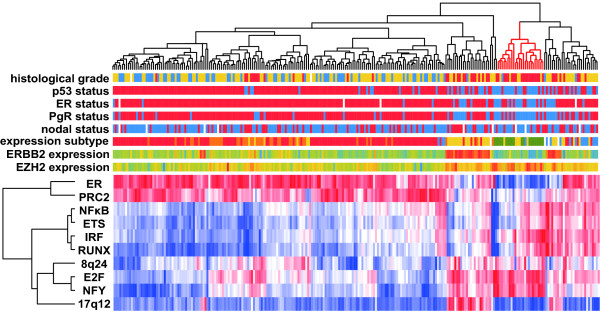
Clustering analysis of expression module activity profiles in breast tumors. Activity profiles of 10 expression modules extracted from breast cancer expression data were analyzed by hierarchical clustering. Red indicates increased activity and blue indicates decreased activity. The upper color bars indicate clinical and gene expression information of each tumor sample; histological grades (G1: red, G2: yellow G3: blue), p53 status (wildtype: red, mutant: blue), expression subtypes, ER, PgR and nodal status (positive: red, negative: blue), ERBB2 and EZH2 expression (increased expression: red, decreased expression: blue). The expression subtypes are based on the five major branches in the clustering dendrogram of the gene expression profiles. In the upper dendrogram, red branches represent a sample cluster which is enriched for triple negative breast tumors.